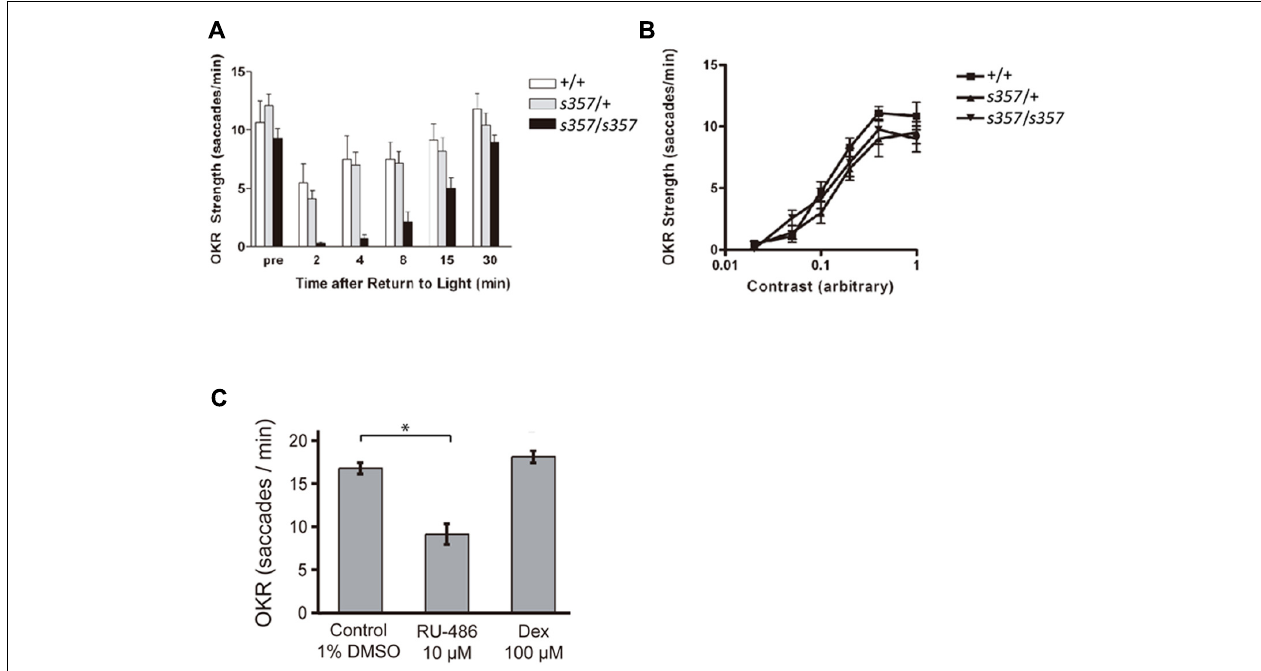
FIGURE 1 | Optokinetic responses are affected by disruption of glucocorticoid signaling. (A) OKR, in saccades per minute, to motion of a constant sine-wave grating at high contrast. Zebrafish (7 dpf) were initially light adapted (pre) and measured at the indicated time points following a 45 min dark period. gr s357 mutants ( n = 7; confirmed by genotyping) recovered more slowly from the dark than either WT ( + / + ; n = 6) or heterozygotes ( s357 / + ; n = 15). Asterisks: significant difference ( p < 0.05). Bars: Standard error of the mean (SEM). (B) Contrast